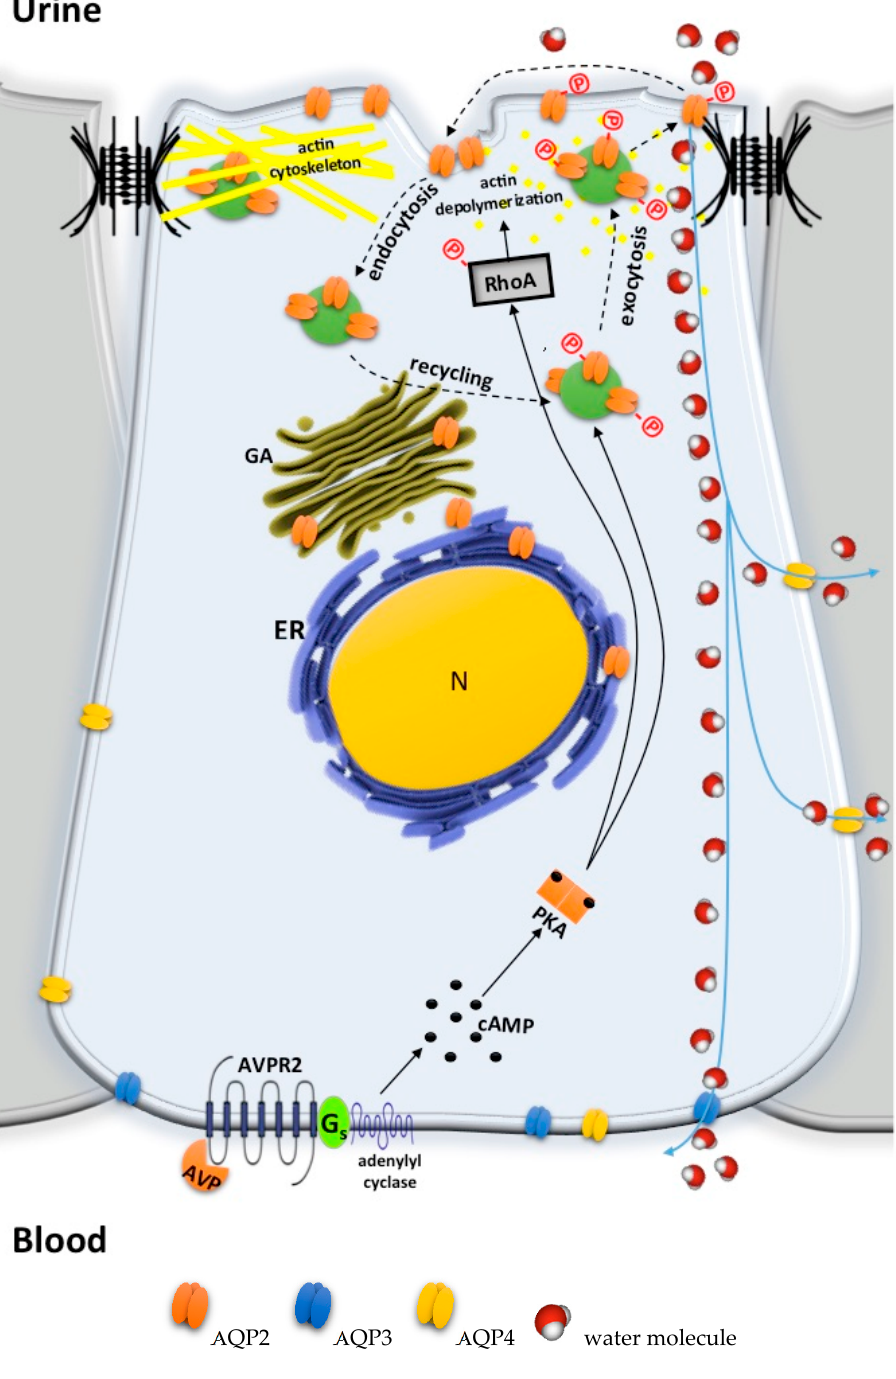
Figure 1. Action of arginine vasopressin (AVP) in the collecting duct principal cells. Upon the binding of AVP to its cognate receptor AVPR2 at the basolateral membrane, a stimulatory G protein α subunit (G s ) activates adenylyl cyclase and increases cyclic adenosine monophosphate (cAMP) intracellular concentrations. This, in turn, activates protein kinase A (PKA), which phosphorylates many substrates, including AQP2 and RhoA (full lines). The partial depolymerization of the sub-apical actin cytoskeleton facilitates the apical exocytosis of AQP2-storage vesicles (dotted lines). Water enters the cells via de novo inserted AQP2 tetramers at the apical membrane and leaves the epithelial cells through AQP3 and AQP4 constitutively expressed at the basolateral membrane. AVP removal from the bloodstream allows AQP2 endocytosis and recycling through early endosomes (dotted lines).